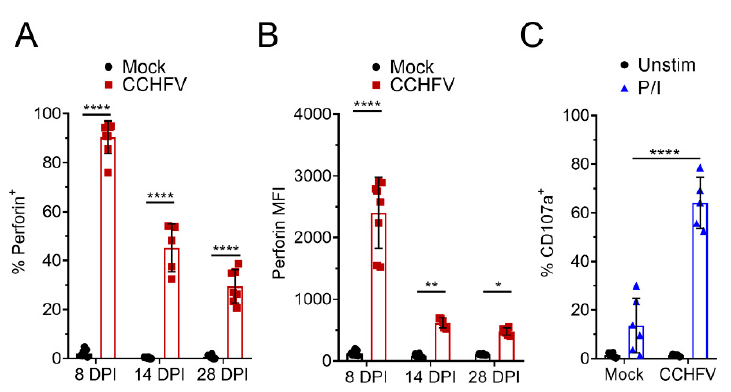
Figure 3. CD8 + T-cells from CCHFV-infected mice express perforin and degranulate. IFNAR − / − mice were infected with CCHFV or mock-infected. At indicated time points, mice were euthanized, single cell suspensions generated from the liver, and analyzed by flow cytometry. ( A – C ) Liver CD8 + T-cells were identified as CD3 + CD4 − CD8 + and ( A , B ) intracellular perforin expression in CD8 + T-cells measured after 4 h ex vivo incubation in the presence of brfA. ( A ) Percent CD8 + T-cells positive for perforin expression and ( B ) the median fluorescent intensity (MFI) of all CD8 + T-cells is shown. ( A , B ) N = 5–8 per group. Error bars indicate standard deviation. Statistical comparison between CD8 + T-cells from CCHFV-infected mice (red) and mock-infected mice (open bar) was performed with a two-way ANOVA with Sidak’s multiple comparison test. ( C ) Degranulation of liver CD8 + T-cells at day 14 PI was monitored by CD107a staining. Percent CD107a + CD8 + T-cells after indicated stimulation in the presence of brfA, monensin, and PE-conjugated CD107a is shown. Unstim = no stimulation. P/I = PMA and ionomycin. Error bars indicate standard deviation. N = 5 to 6 per group. Statistical comparison between